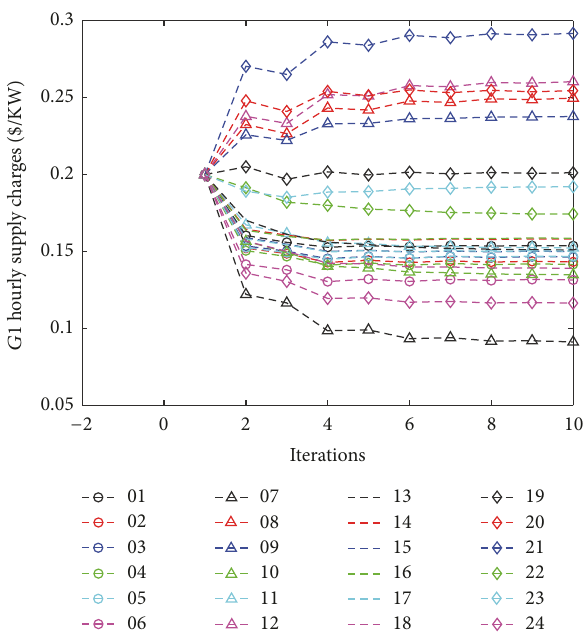
Figure 4: The hourly supply prices trajectories of G